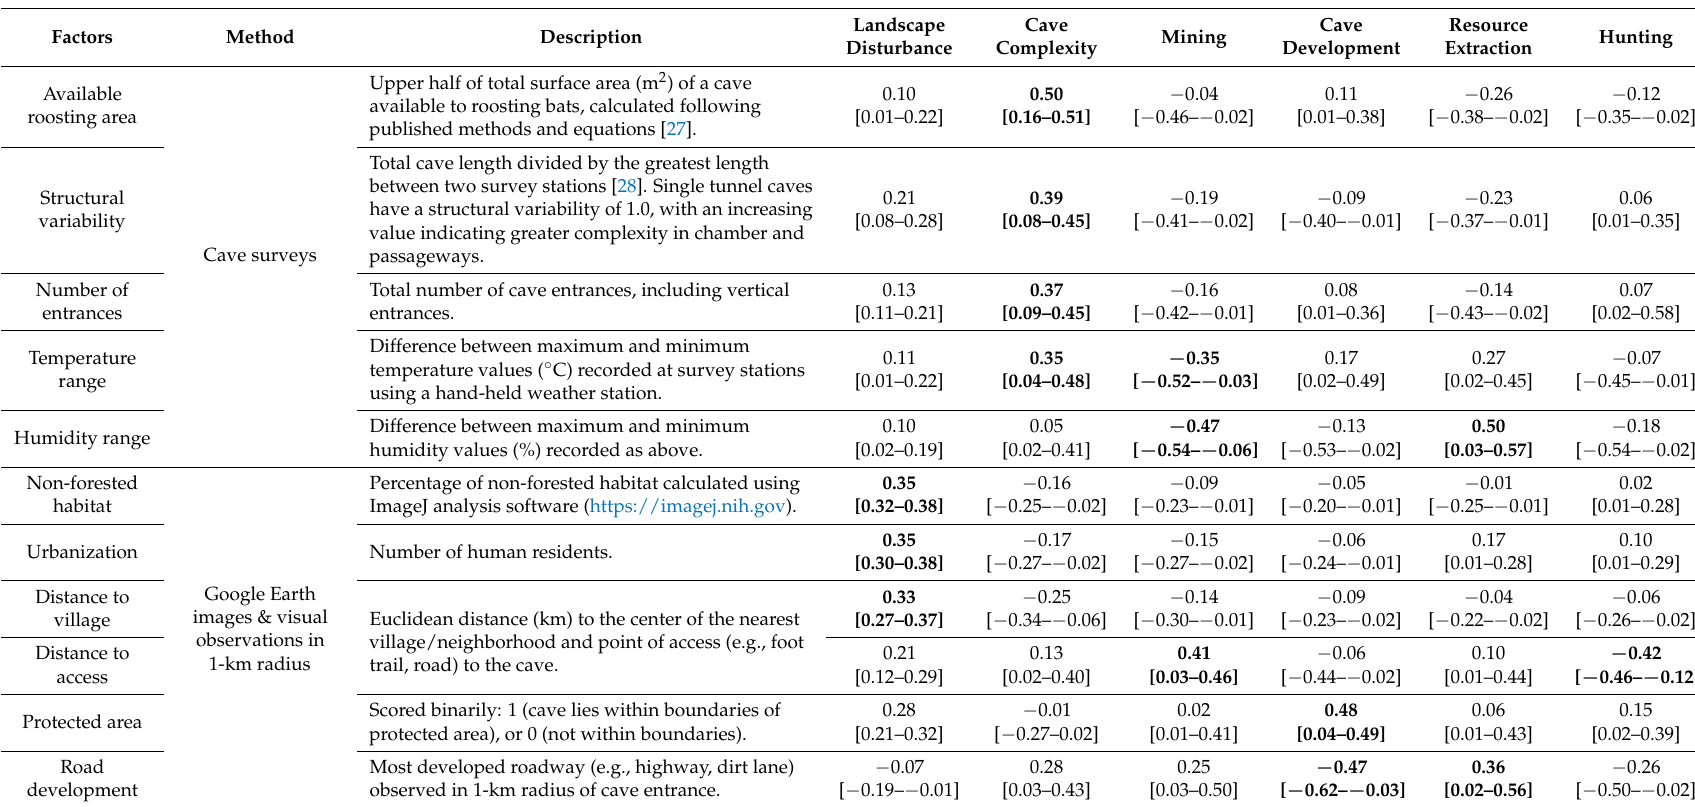
Table 1. Description of the 18 environmental and human disturbance factors measured at 56 caves on Bohol Island, the Philippines, with principal component loadings of each factor for the six gradients included in our